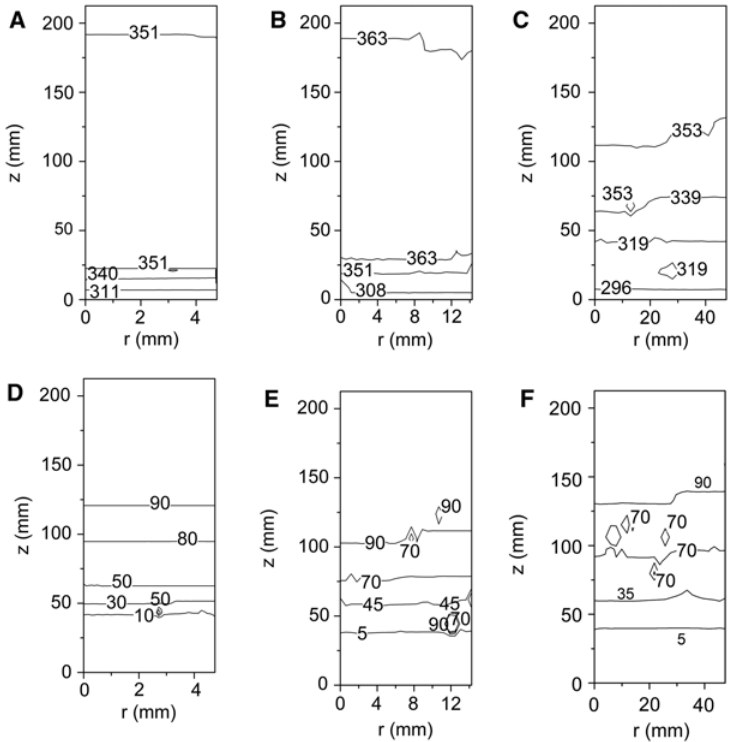
Figure 3: Temperature (A–C) and 2-methyl-3-butyne-2-ol (MBY) conversion (D–F) maps in the 11 zone reactors. Reactors: (A, D) R-5 mm, (B, E) R-15, (C, F) R-50 mm. Reaction conditions are the same as those in Figure 2.